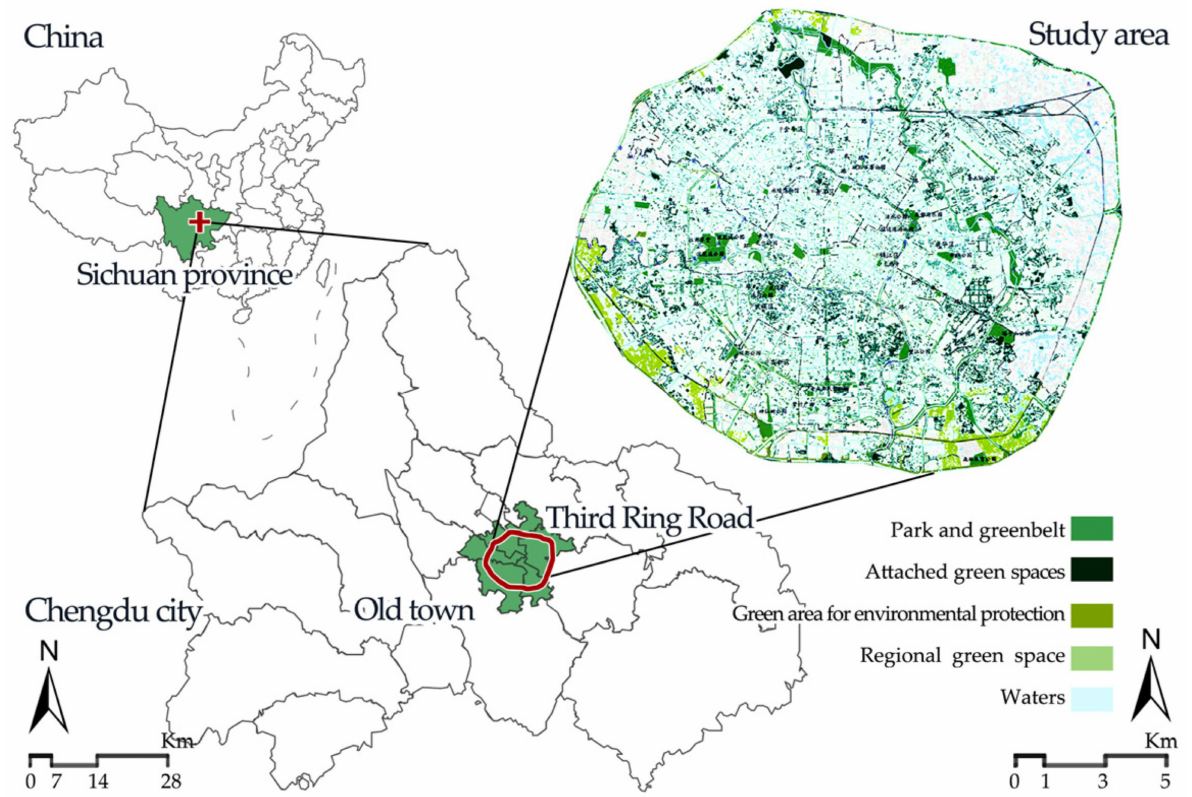
Figure 1. Geographical location of the Chengdu Third Ring Road